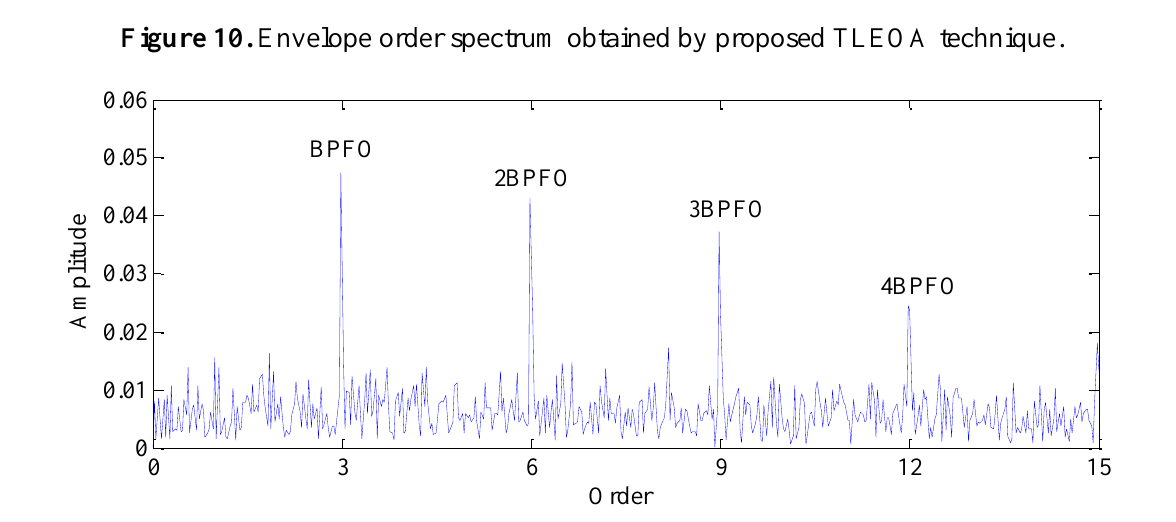
Figure 10. Envelope order spectrum obtained by proposed TLEOA